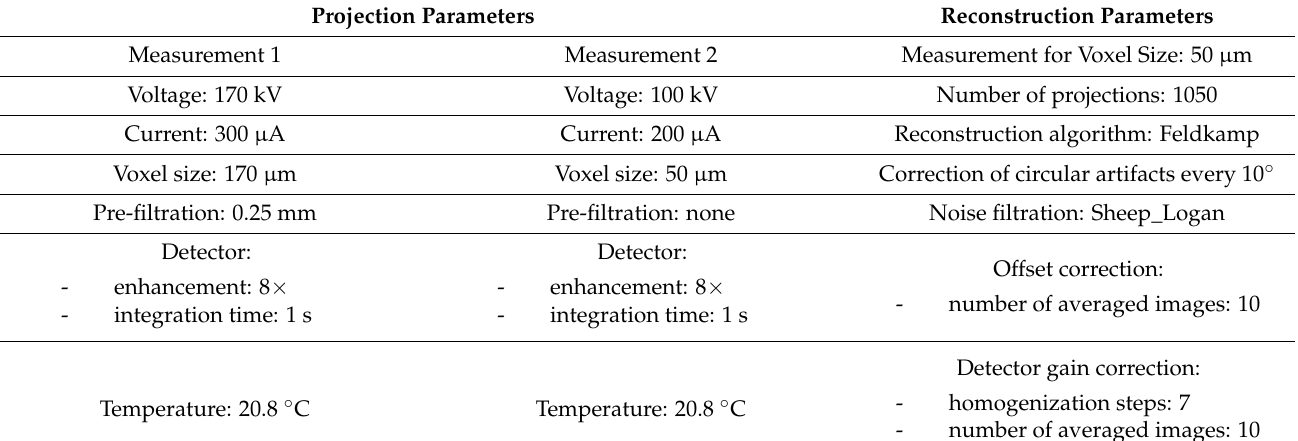
Table 5. Projection and reconstruction parameters of the biocomposite microstructure image using computed tomography. Projection Parameters Reconstruction Parameters